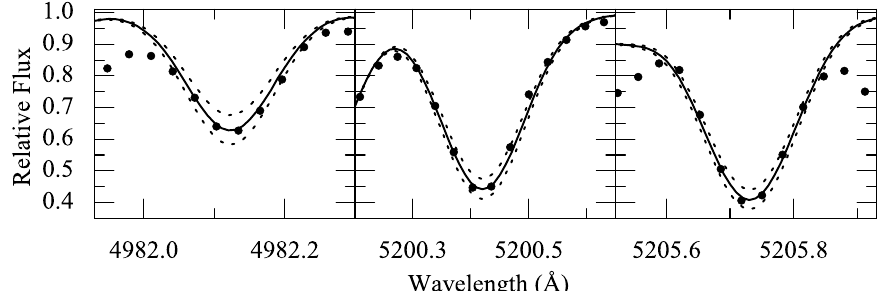
Fig. 16. Three Y II lines in the spectrum of HD 209621. The three synthetic profiles are given for the yttrium abundance log ϵ (Y) = 1 . 07 ± 0 . 15.